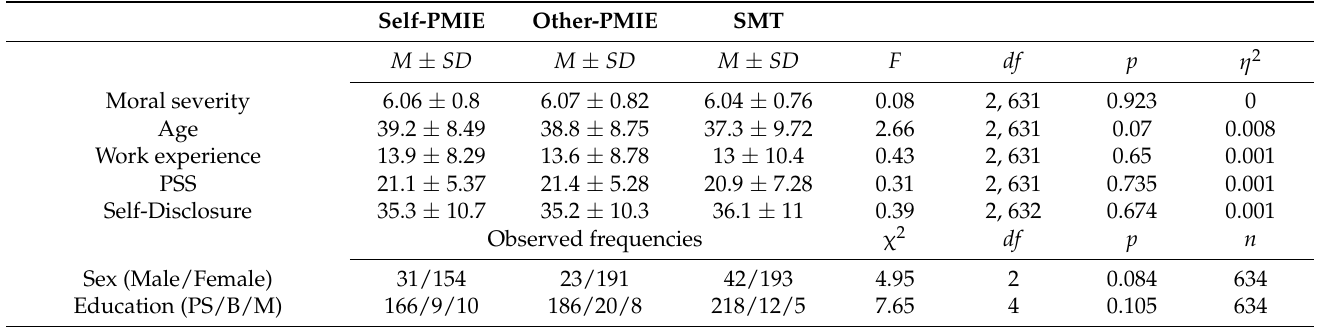
Table A1. Differences between the three experimental groups according to perceived moral severity, age, work experience, perceived supervisor support, self-disclosure, sex, education. Self-PMIE Other-PMIE